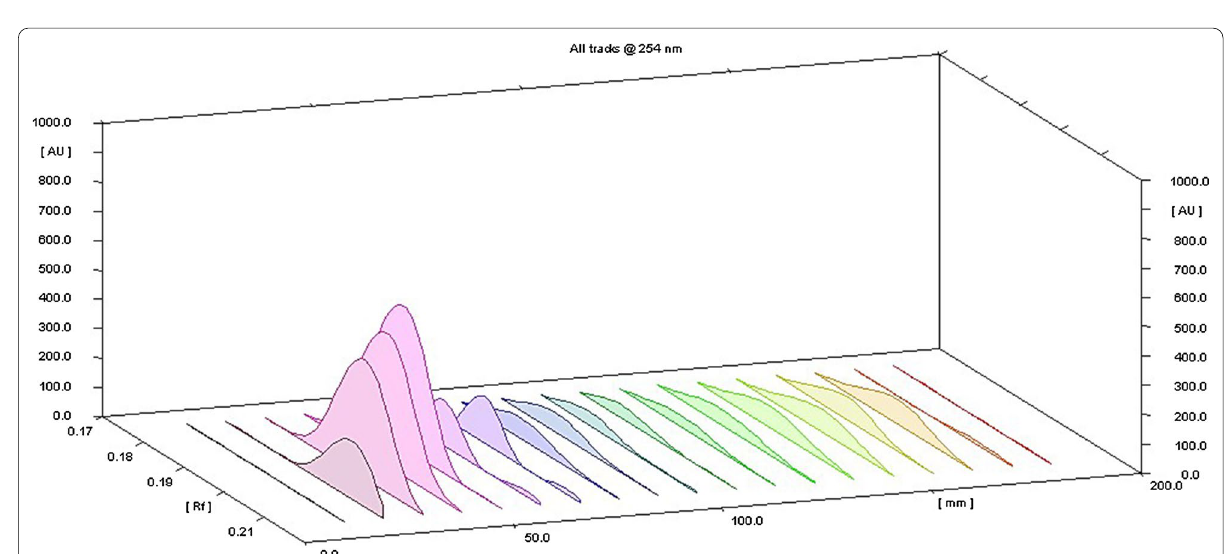
Fig. 5 3-D chromatogram of colchicine in all tracks (standard and samples). 1st–5th tracks meant for standard, 6th–19th tracks belong to in vitro tuber samples in duplicate